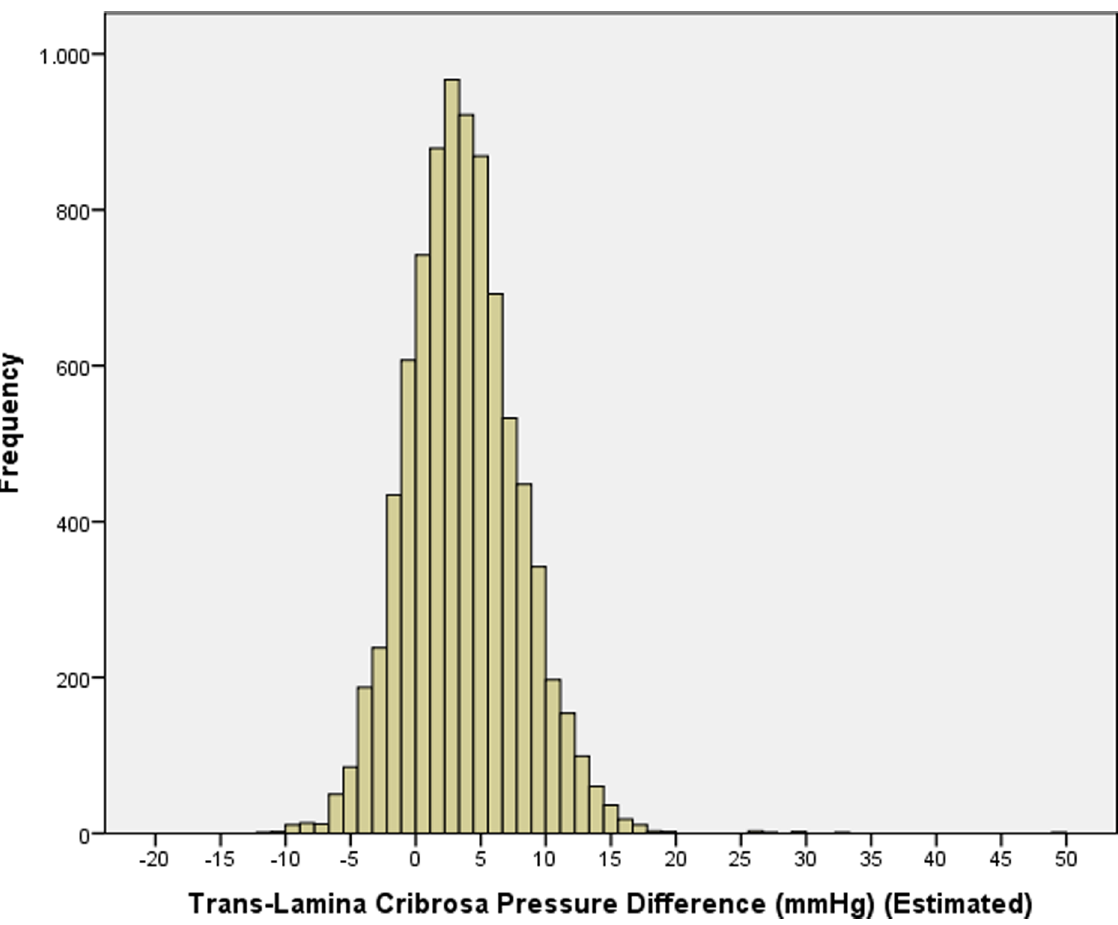
Figure 1. Histogram showing the distribution of the estimated trans-lamina cribrosa pressure difference in the non-glaucomatous eyes of the Central India Eye and Medical Study.